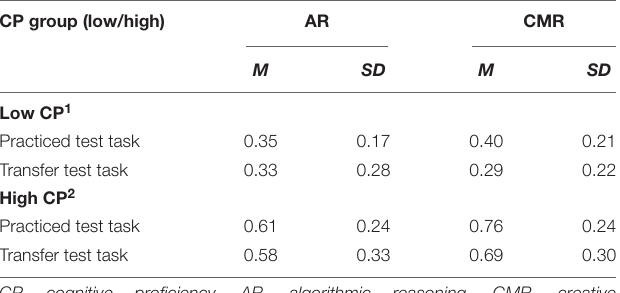
TABLE 2B | Mean proportion correct response ( M ) and standard deviations ( SD ) for AR and CMR learning conditions across low and high CP groups. CP group